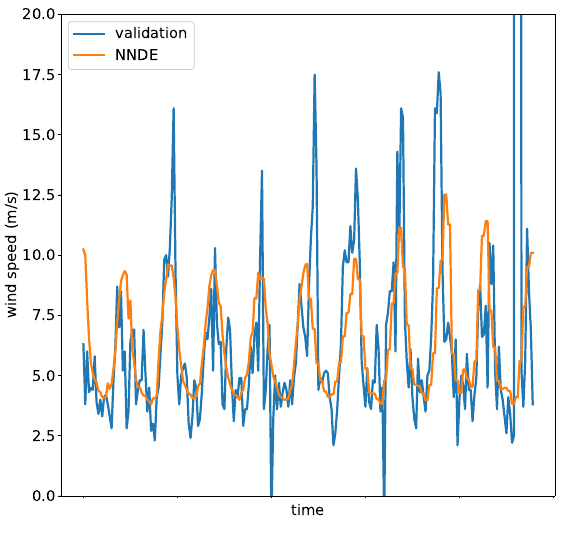
Figure 8. Nearest Neoghbors with Differential Evolution (NNDE) Forecast for the Malpais Validation